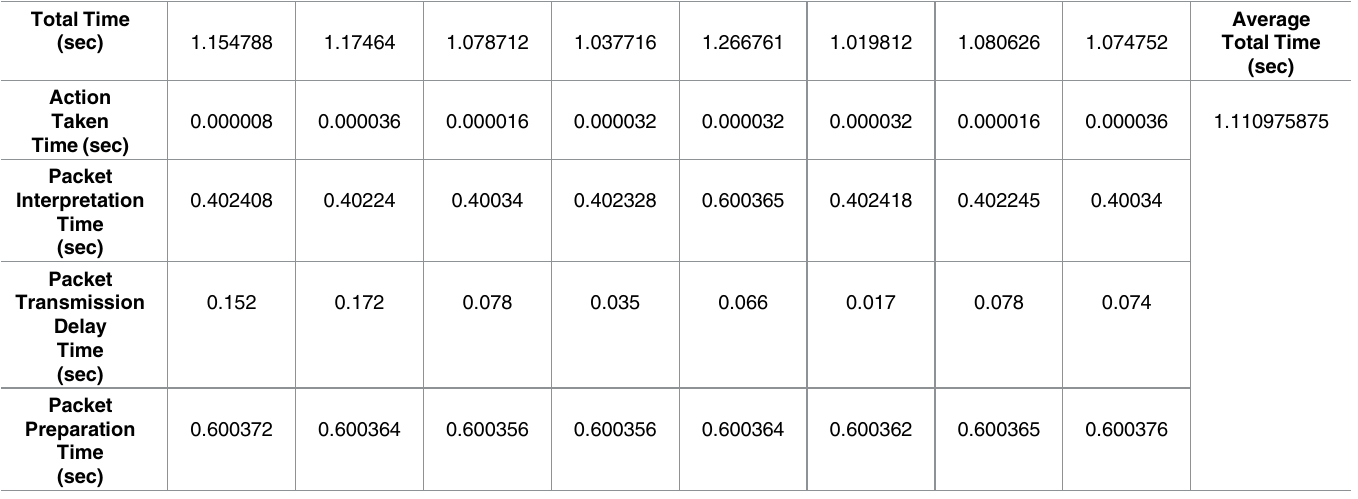
Table 4. Results of prototype experiments in terms of the time taken by the IEEE 802.11n based mirror neuron inspired intention awareness and cooperative perception approach [32] for the collision avoidance in the flock like